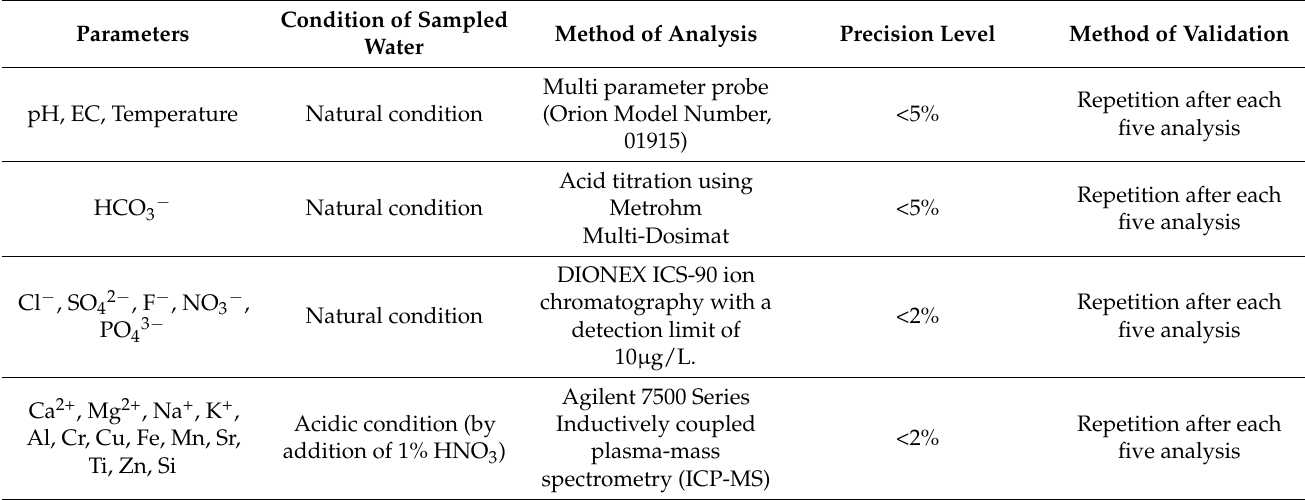
Table 1. Statistical summary for observed water quality